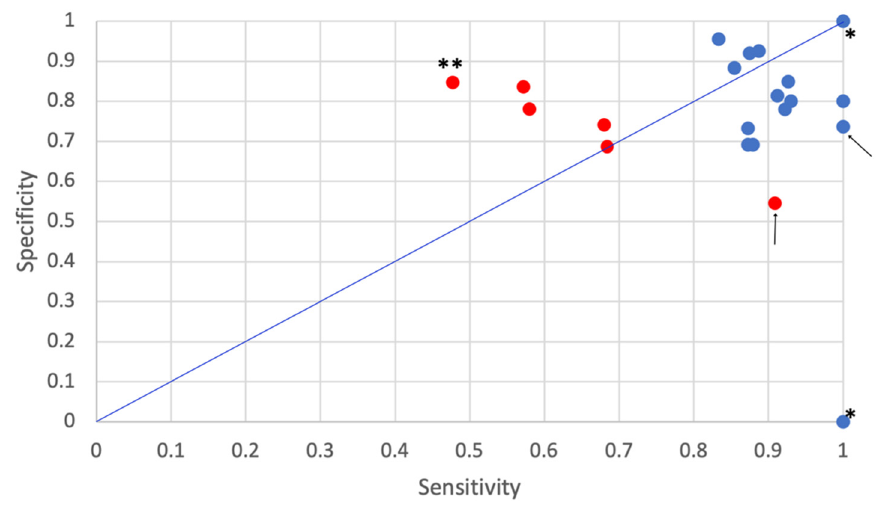
Figure 9. Specificity versus Sensitivity from studies using classification methods/models (presented in Table 10). Data from studies using models with machine learning are represented by blue dots and data from studies using models without machine learning are represented by red dots. The blue line indicates specificity = sensitivity. Data from evaluations using methods other than CV (hold-out or independent dataset) are marked with arrows. Two data points from [29] are marked with asterisks and one data point from [41] is marked with double asterisks.